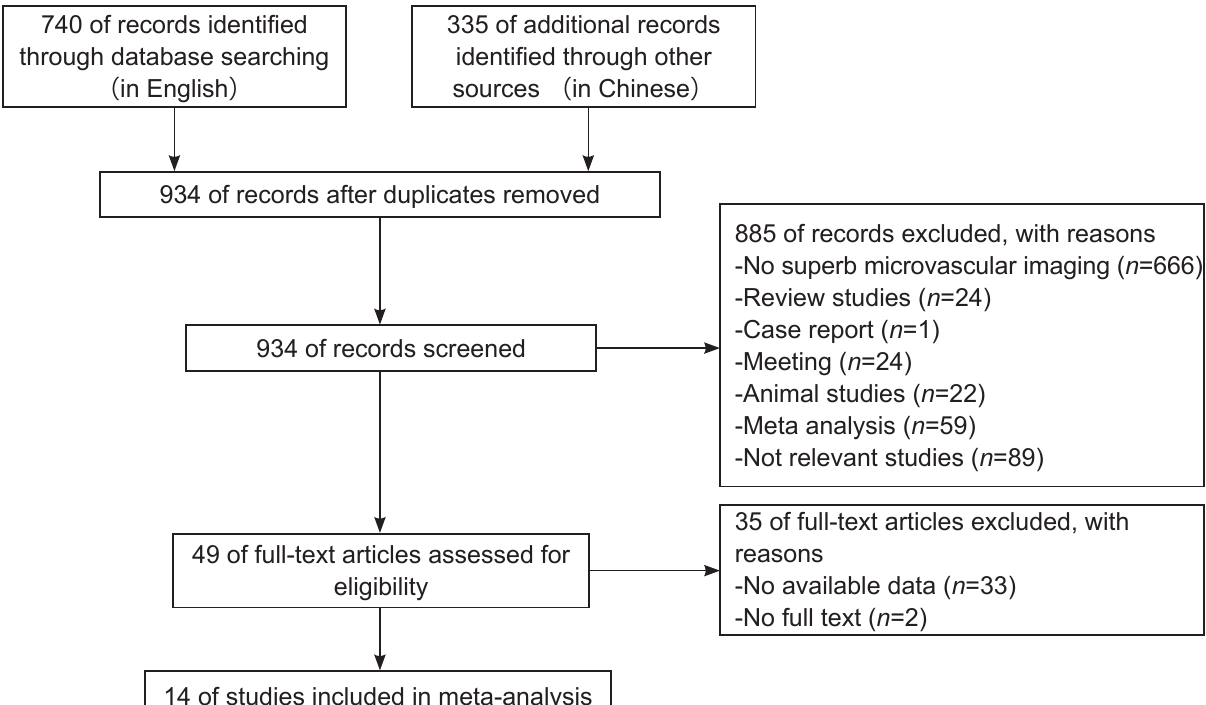
Figure 1 The selection process for studies included in the